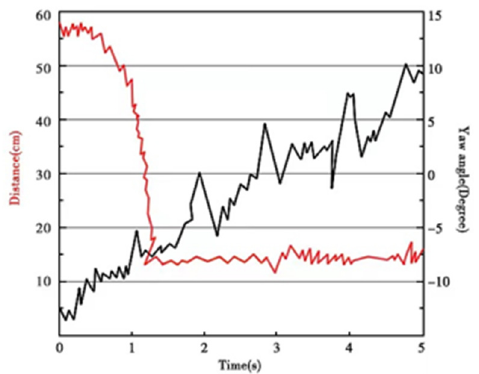
Figure 25. Yaw angle and the dive distance of the son underwater robot.